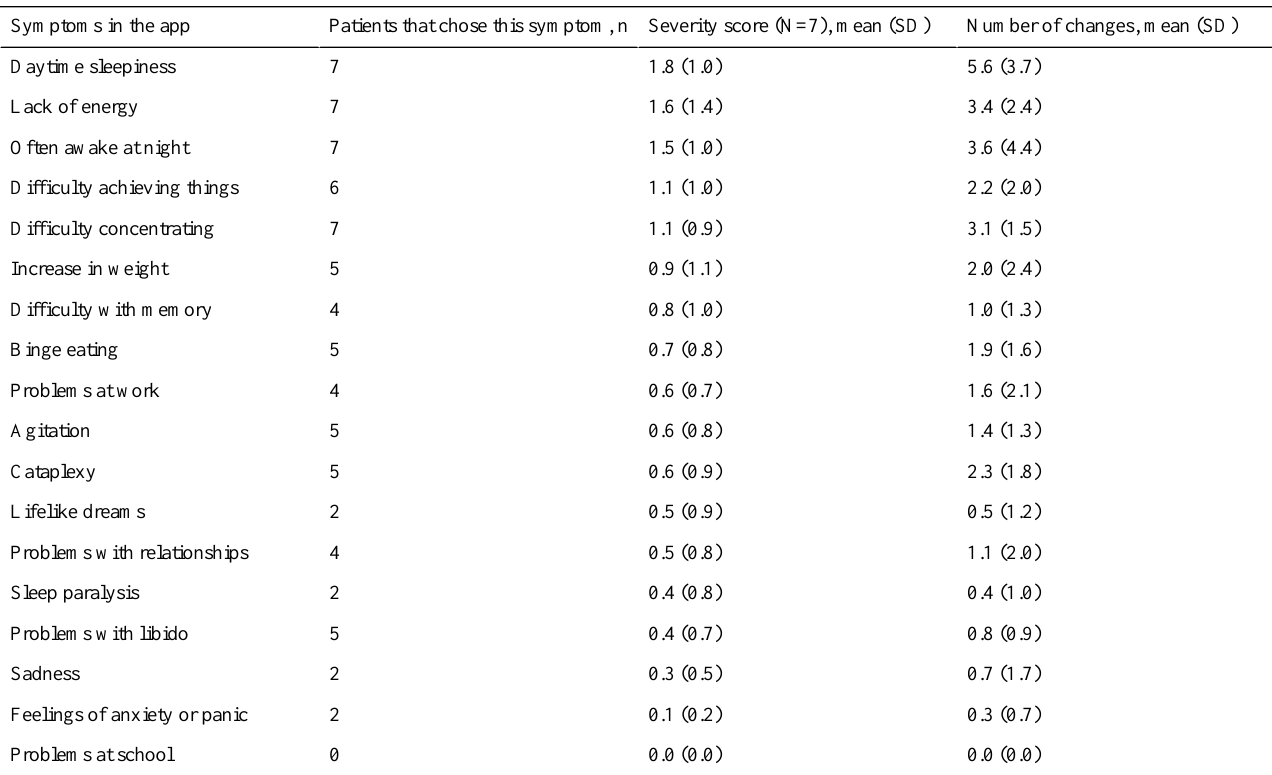
Table 1. Mean symptom scores and dynamics of the symptoms.